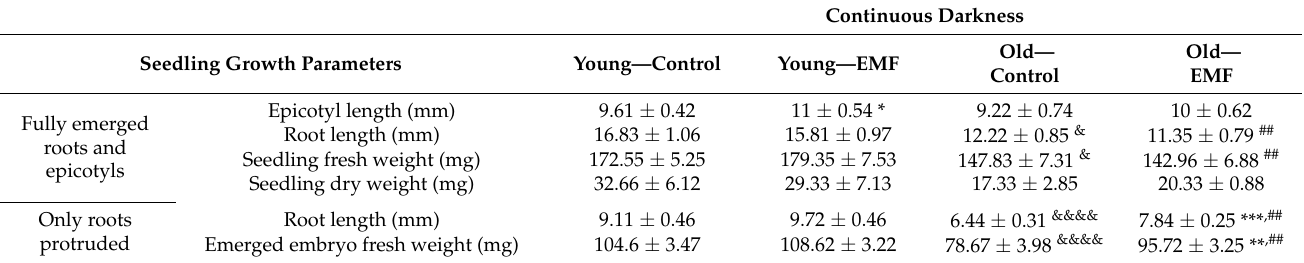
Table 4. The effects of EMF on growth parameters of field bean seedlings cultivated in Petri dishes for 6 days in continuous darkness.